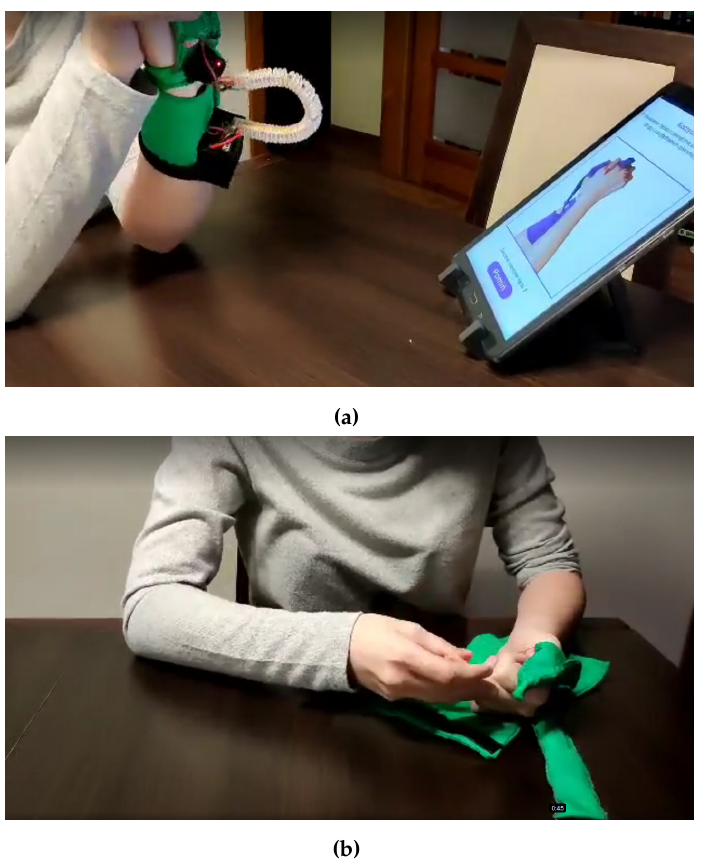
Figure 17. Photographs from a trial session with a Przypominajka user. ( a ) Patient training with Przypominajka v2. ( b ) Patient putting on the Przypominajka